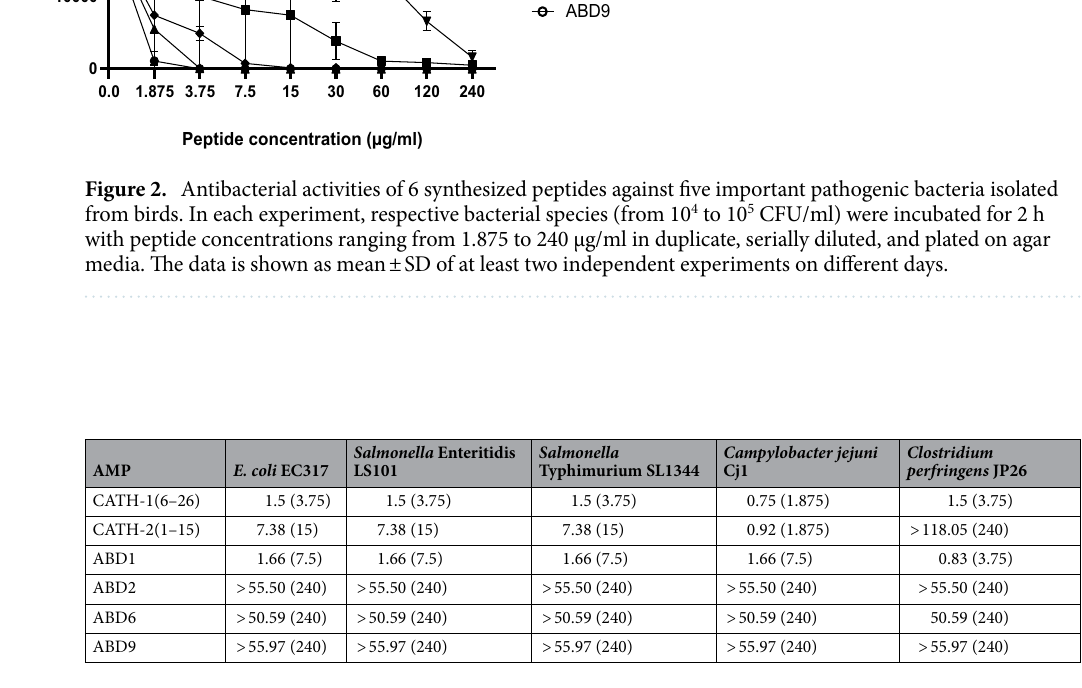
Table 2. Minimum inhibitory concentration (MIC) of peptides that kill 100% bacteria (10 4 –10 5 CFU/ml). Concentrations are displayed in µM and weight (µg/ml; in the brackets) for each